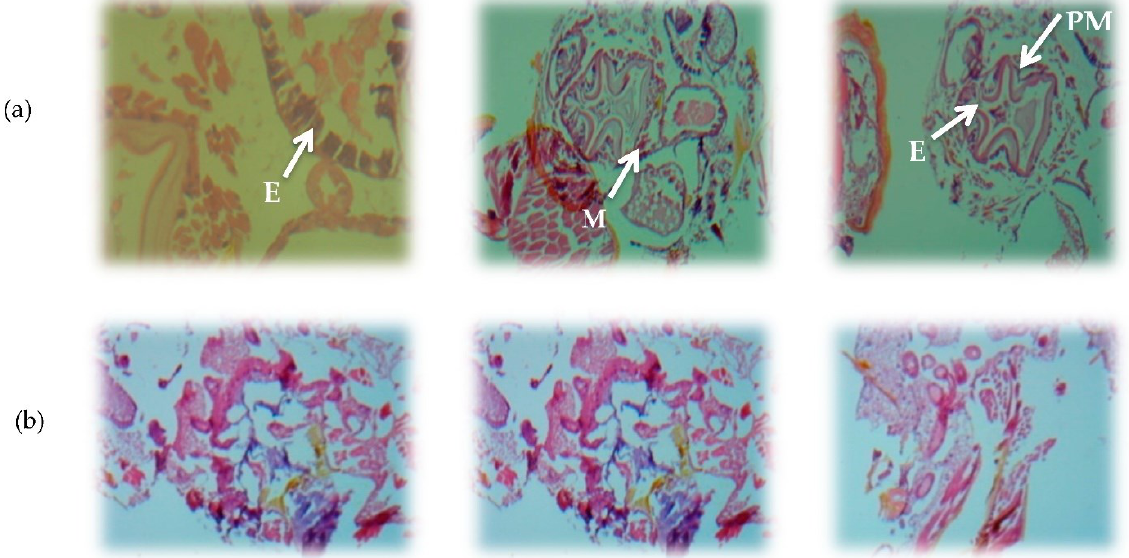
Figure 1. ( a ) Abdominal sections in the nonirradiated S. oryzae adults (control). ( b ) Abdominal sections in the S. oryzae adults after 48 h of gamma irradiation at 1.00 kGy. PM = Peritrophic membrane, M = Muscles, E = Epithelial cells.